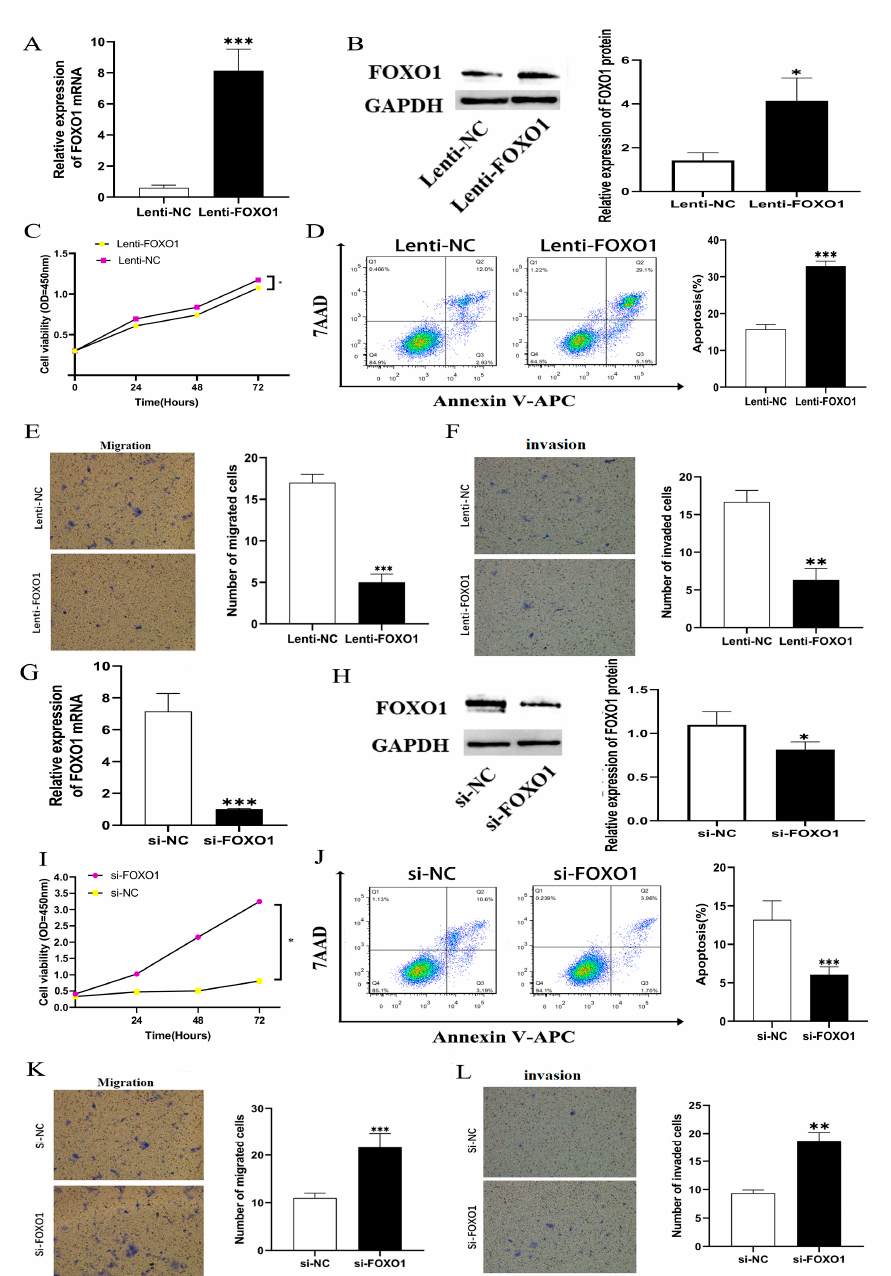
Figure 9. ( A , B ) QRT-PCR and western blot showed that expression of FOXO1 mRNA and